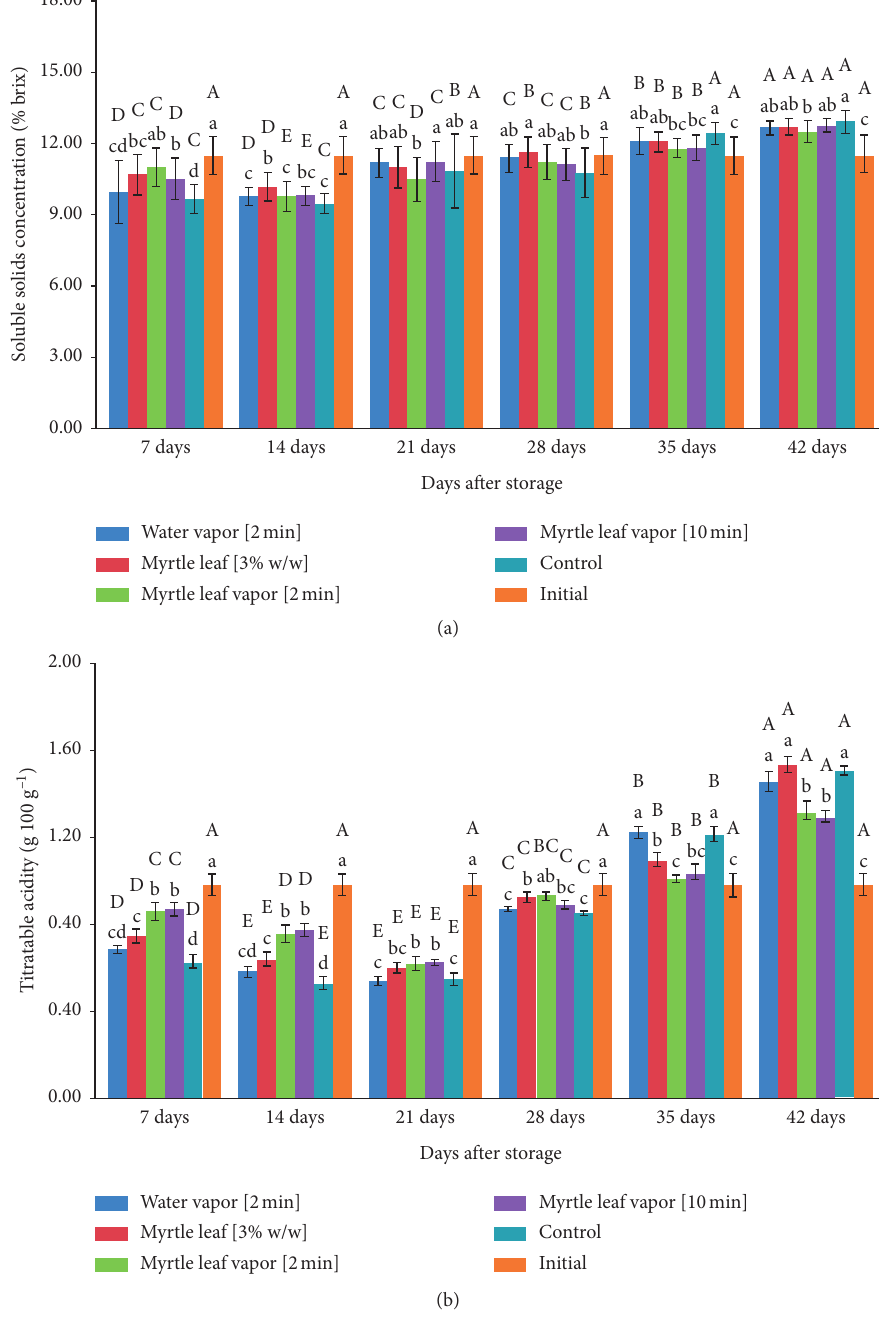
Figure 3: Effects of volatile essential oils of myrtle leaves on the (a) soluble solids concentration and (b) titratable acidity of loquat fruits during 42 days of storage. Different lowercase letters denote significant differences among different treatments for the same sampling time, and different capital letters denote significant differences among different sampling times for the same treatment, according to Tukey’s HSD test at P < 0 .